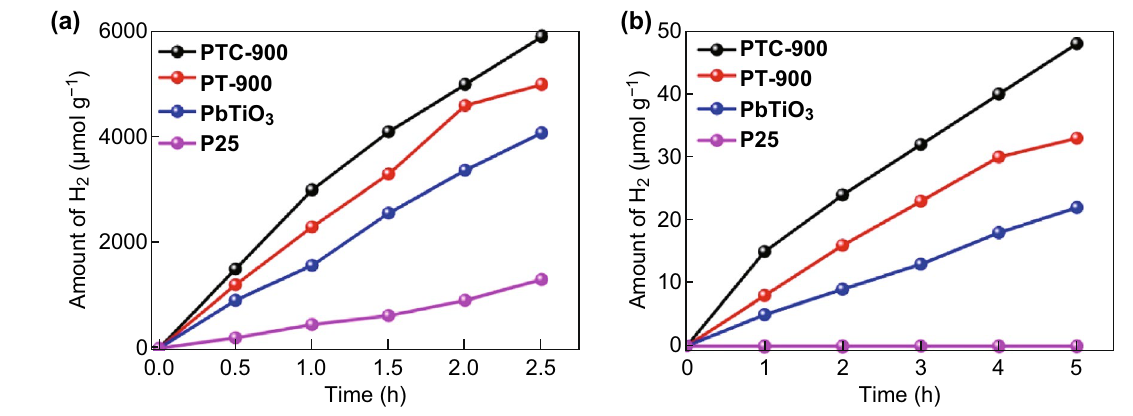
Fig. 6 Photocatalytic hydrogen production of different photocatalysts loaded with 2% Pt as co-catalyst under a UV and b visible light irradiation